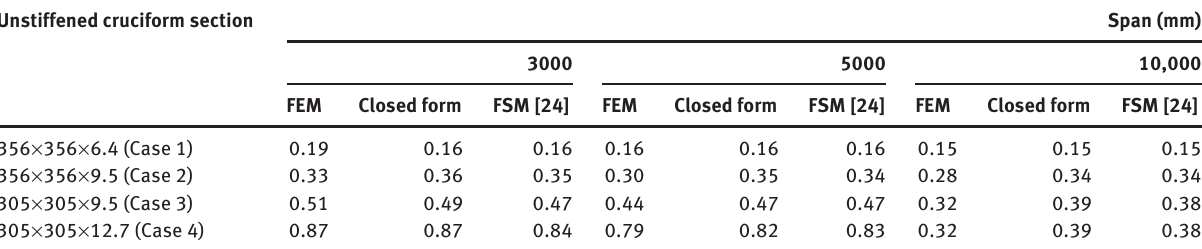
Table 9 Effect of the web (or flange) thickness on the normalized critical buckling stresses for unstiffened cruciform-shaped section. Unstiffened cruciform section